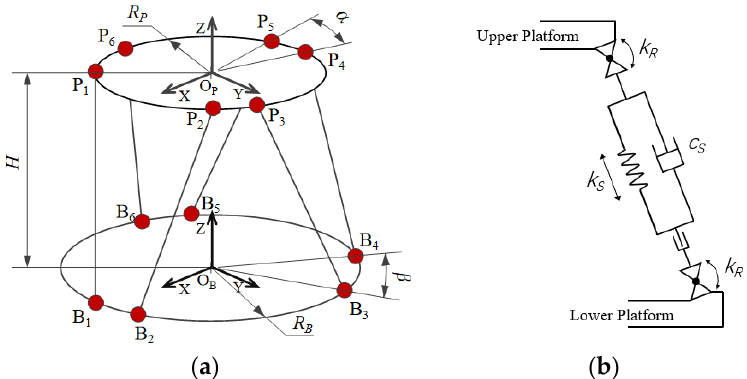
Figure 1. Structure diagram of Stewart platform: ( a ) Schematic diagram of platform structure; ( b ) Schematic diagram of platform leg link with Flexible joint.